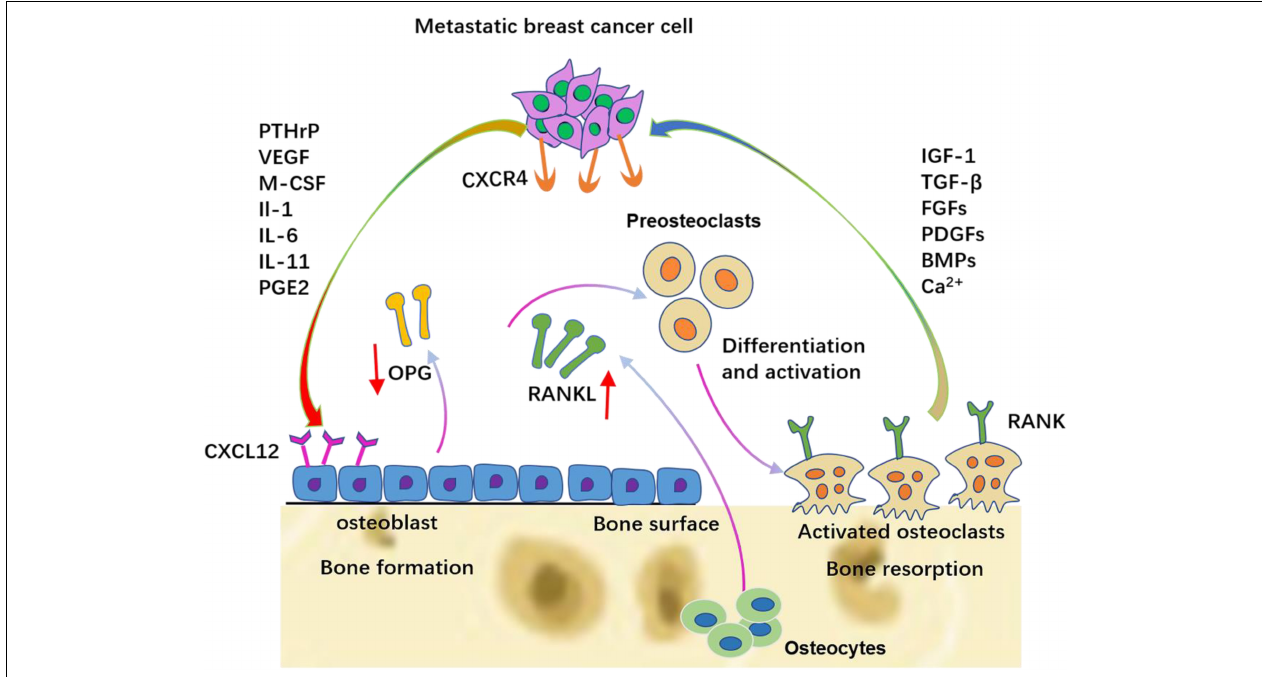
FIGURE 3 | The vicious cycle between breast cancer cells and bone. Breast cancer cells secrete soluble factors, including PTHrP, VEGF, IL-6, IL-8, and IL-11, which in the bone metastatic site act on osteoblasts/osteoclasts. The production of RANKL is increased and the production of OPG is decreased from osteoblasts. Late-stage pre-osteoclast cells respond to specific breast cancer-secreted factors by differentiation and osteolytic